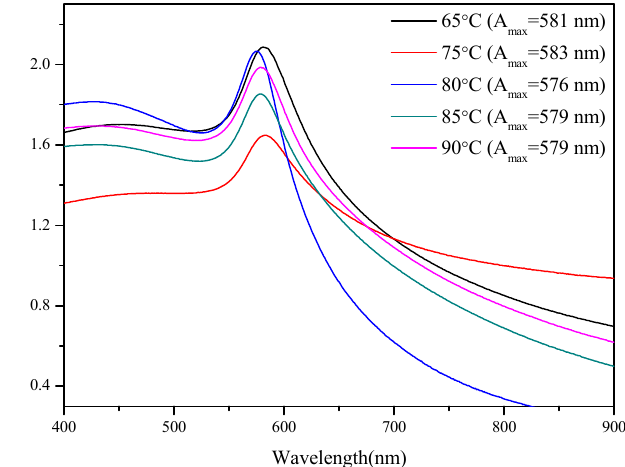
Figure 7. UV–vis spectra of CuNPs synthesized under secondary reduction at temperatures of 65 °C, 75 °C, 80 °C, 85 °C, and 90 °C.